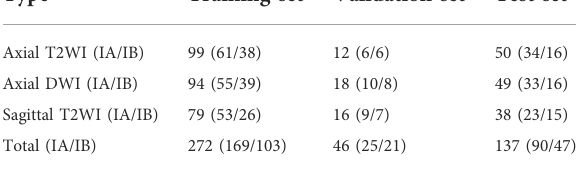
TABLE 3 Details of the data set